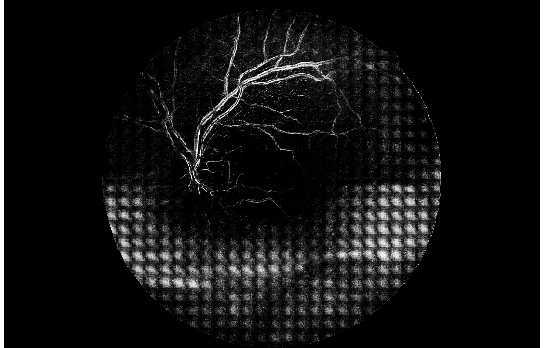
Figure 8. Retinal image (low quality).